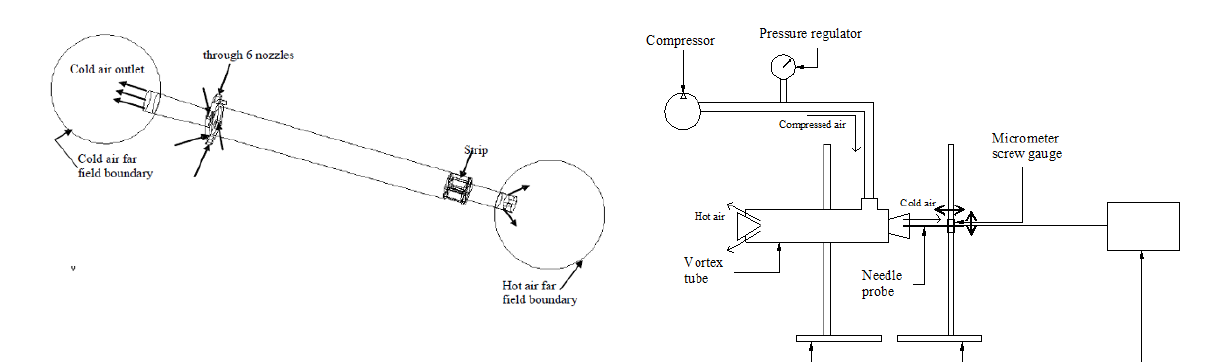
Figure 2. Computation domain of the vortex tube.